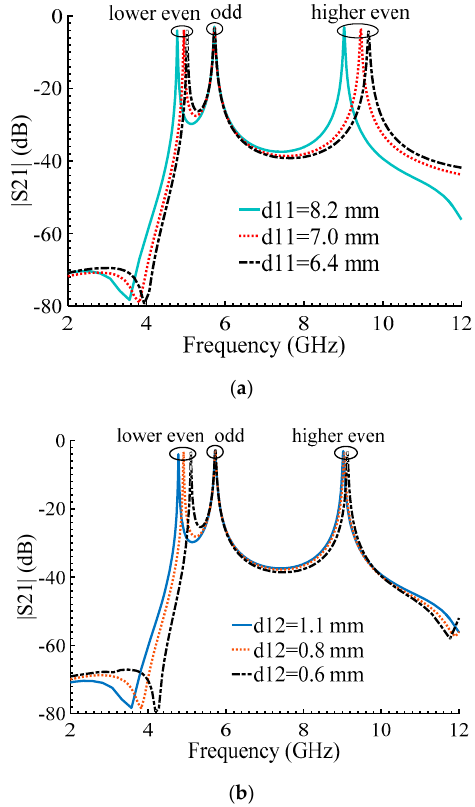
Figure 5. Tunability of the modal resonances of the bent T-shaped resonator: ( a ) Tunability of the higher even mode resonance using d11, ( b ) tunability of the lower even mode resonance using d12. The proposed structure is formed using two small L-shaped stubs added to the bent T-shaped resonator for generating the second passband, as shown in Figure 6a. Figure 6b depicts the second passband fixed at 11.5 GHz.